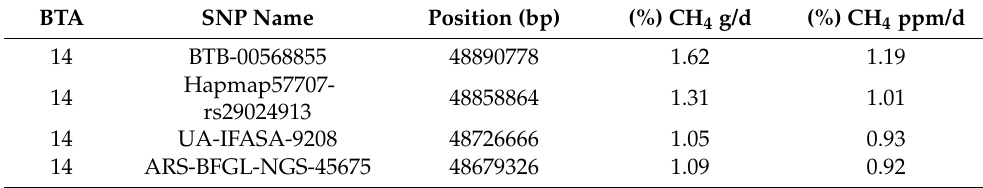
Figure 6. Manhattan plot for % of genetic variance explained by 50-SNP windows for CH4 g/d, with an arbitrary threshold line of 1%. Table 2. Candidate SNPs detected for both CH 4 g/d and CH 4 ppm/d, their position in base pairs, and percentage of genetic variance explained by them (%).